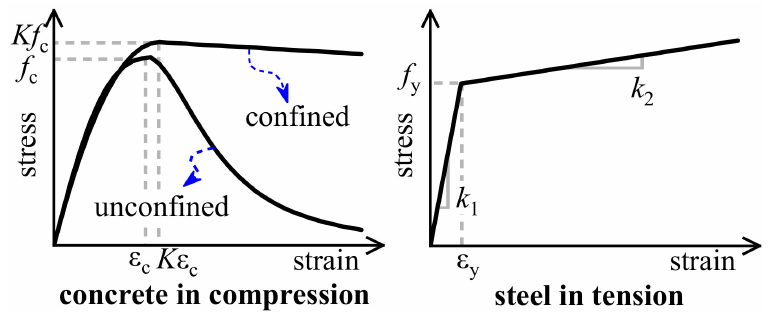
Figure 4. Simplified constitution of